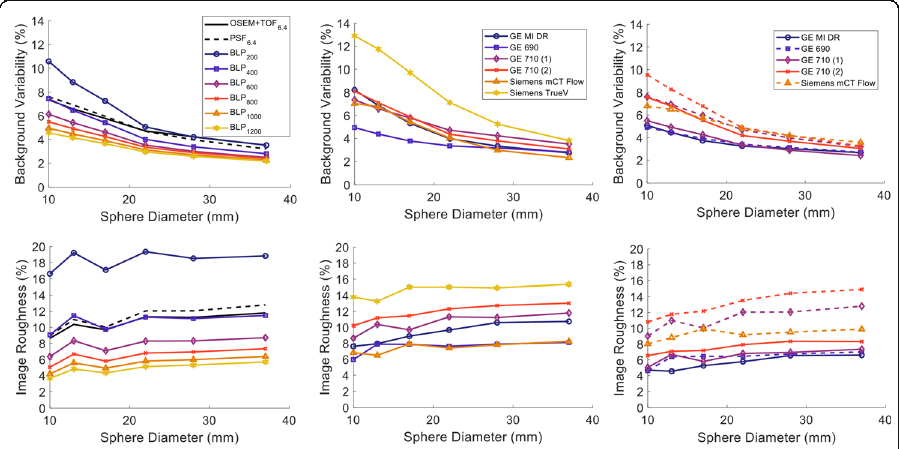
Fig. 8 Background variability (top row) and image roughness (bottom row) for Gallium-68 acquisitions of the NEMA IQ phantom. The left column displays the metrics for varying β values of the BPL reconstruction including OSEM+TOF 6.4 and PSF 6.4 , the middle column the OSEM and OSEM+TOF reconstructions for six different sites and the right figure for the advanced reconstructions